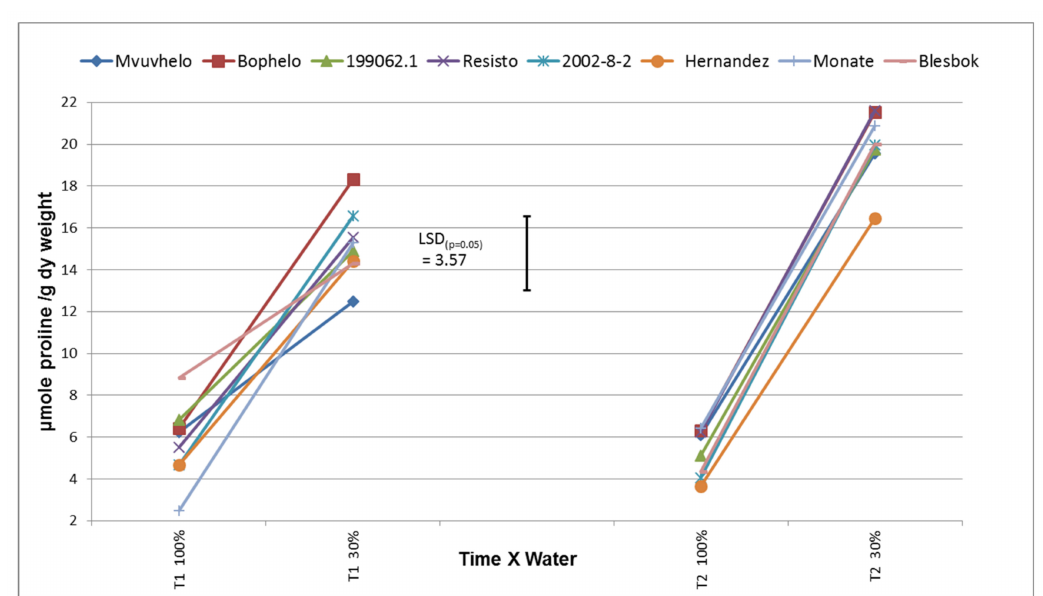
Figure 8. Proline concentrations in the leaves of eight sweet potato cultivars and breeding lines subjected to drought. LSD = 3.57; T1 = 60 days after planting; T2 = 120 days after planting. ( p = 0.05) 100% = control treatment; 30% = severe stress treatment.